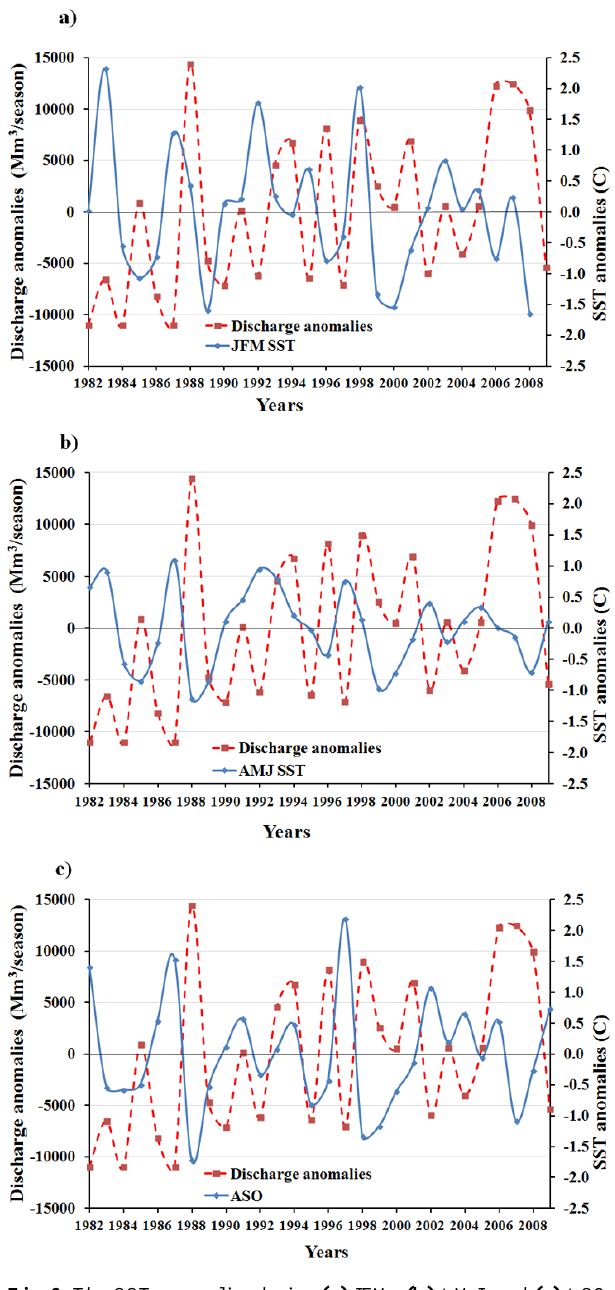
Fig. 6. The SST anomalies during (a) JFM, (b) AMJ, and (c) ASO in Niño 3.4 region and the discharge anomalies in Eldiem station during JJAS from 1982 to